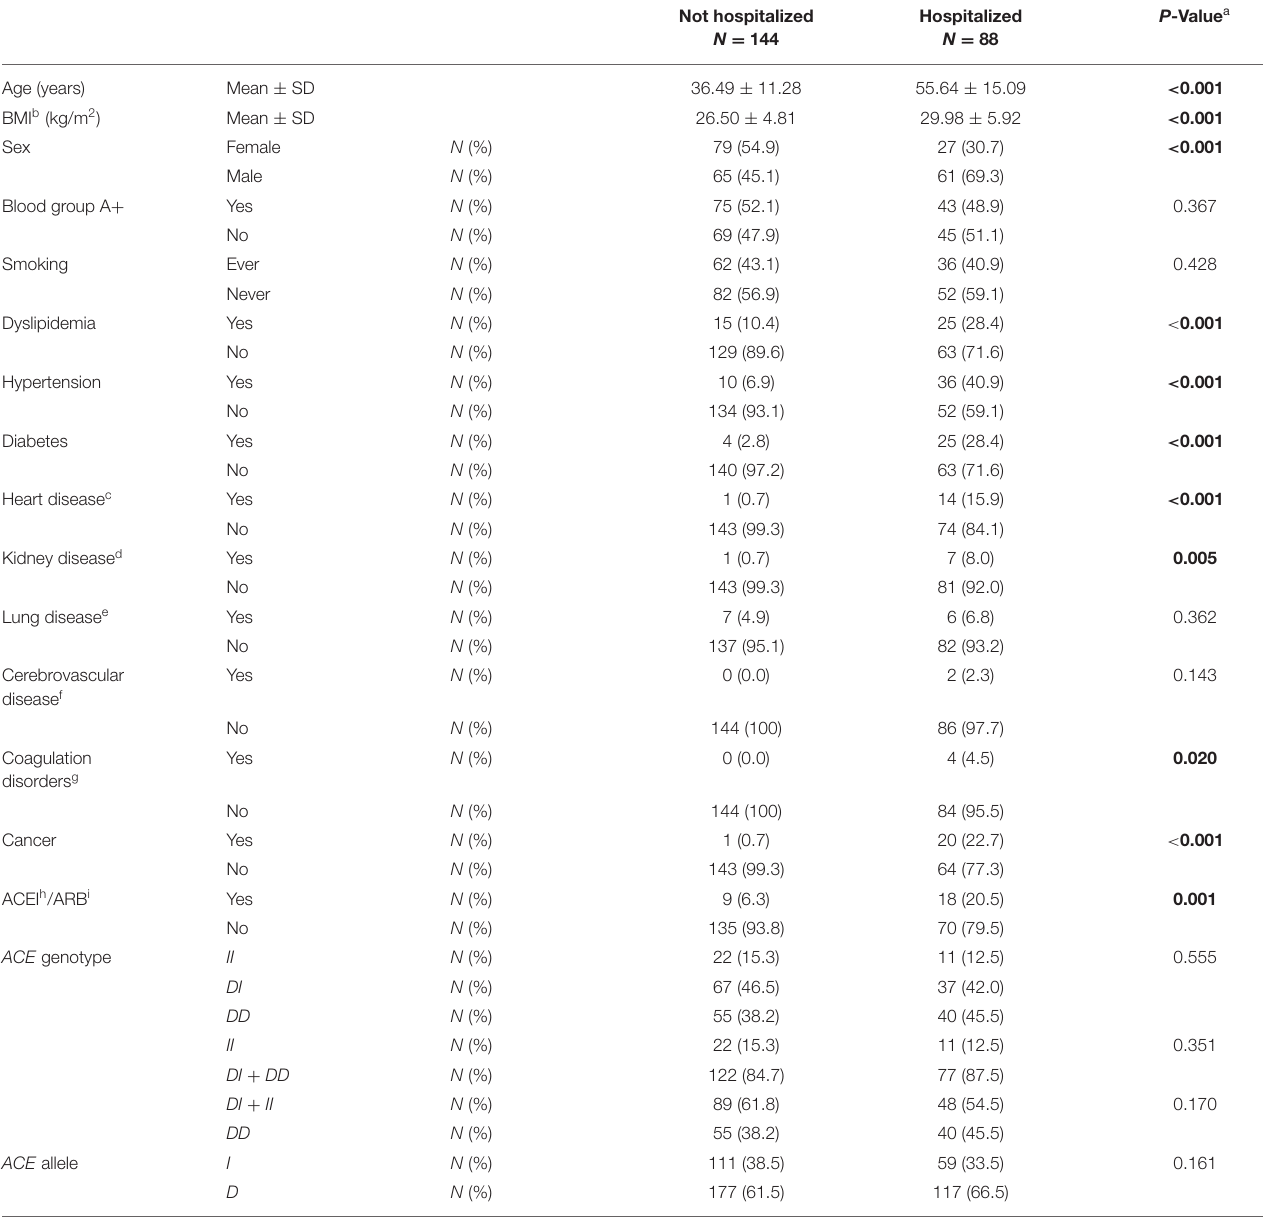
TABLE 3 | Association between baseline characteristics and ACE1 polymorphism with hospitalized vs. non-hospitalized COVID-19 cases.